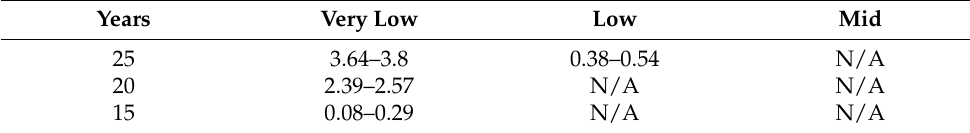
Table 19. BEIS Range of Balance Model.